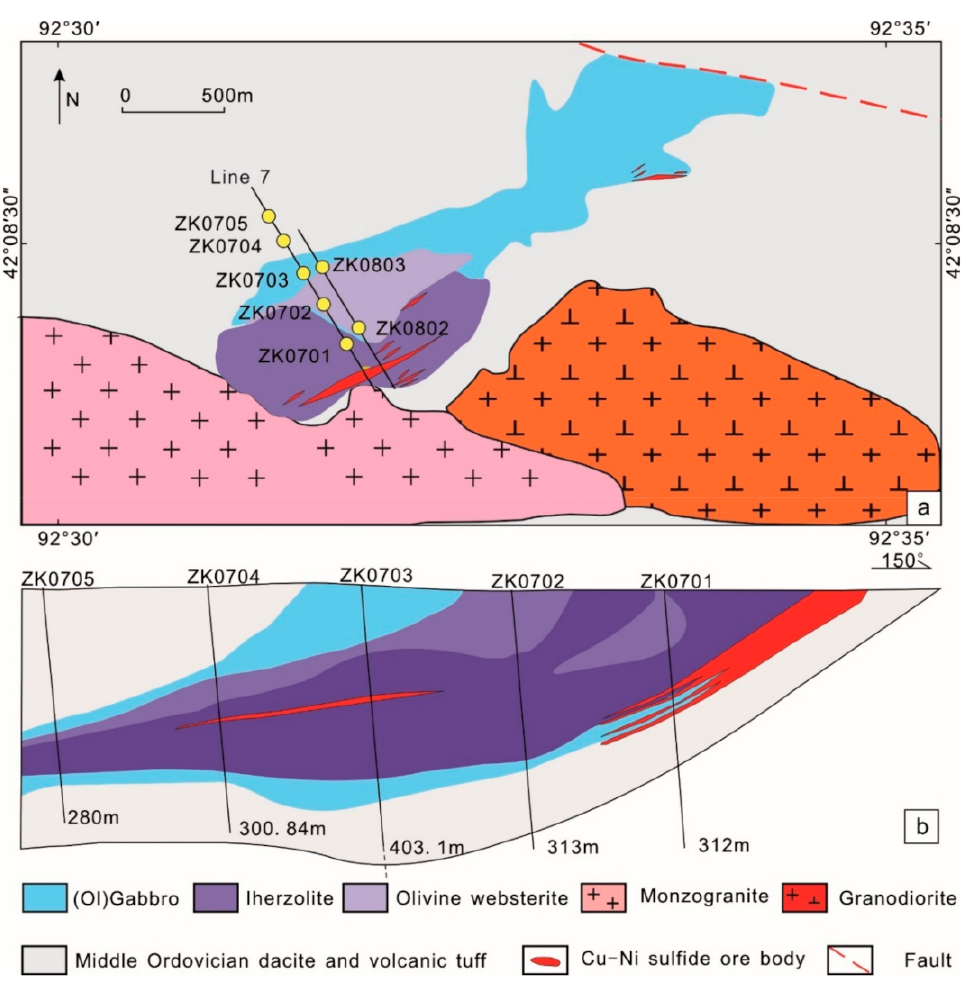
Figure 2. ( a ) Simplified geological map and ( b ) section of line 7 of the Baixintan deposit, showing the distribution of mafic and ultramafic rocks and sulfide